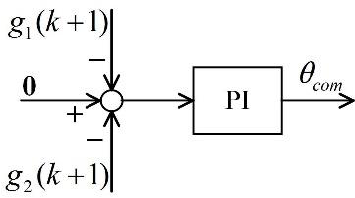
 . Figure 3. PI regulator used to tune the θ com . com